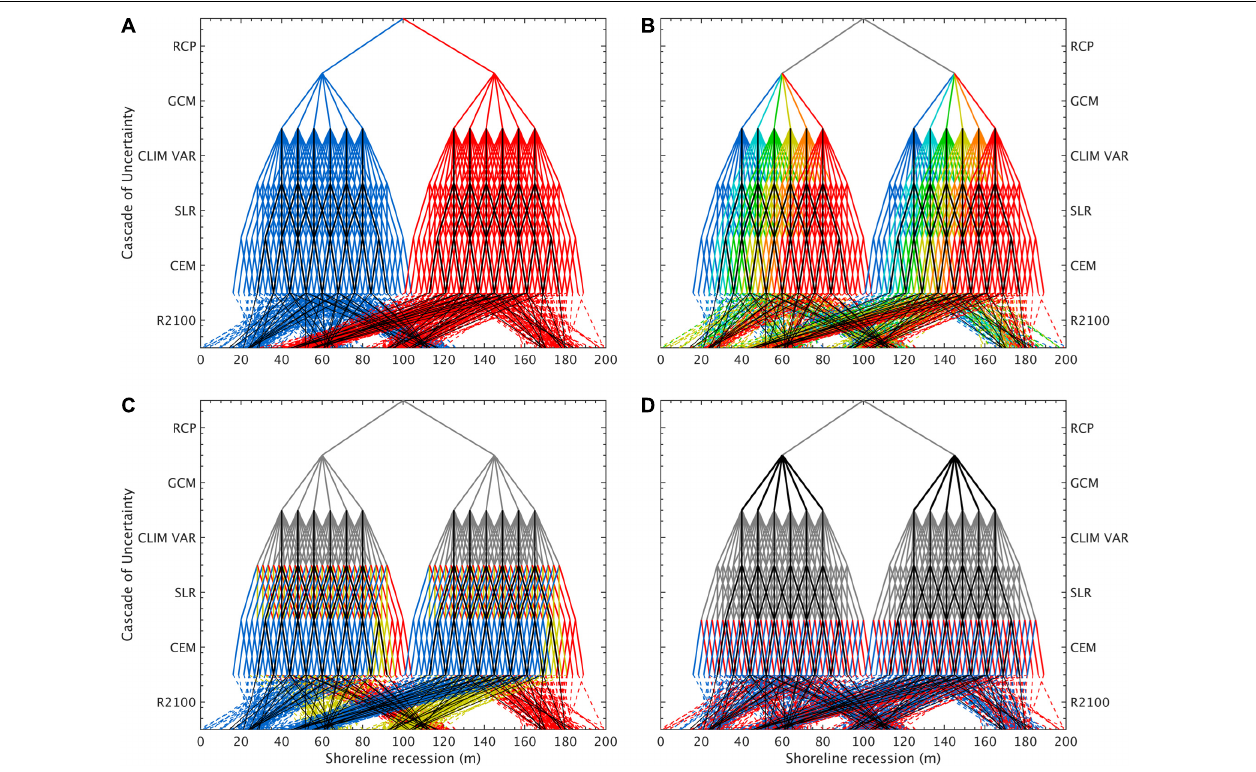
FIGURE 6 | Visualisation of the cascade of uncertainty in coastal erosion projections by 2100 using SP1 and SP3 simulations. SP1 data (720 simulations out of 72,000) is displayed as in Figure 5 and SP3 data (72 simulations) are superimposed and represented by solid black lines. From top to bottom: first layer shows the 2 RCPs, second layer shows the ensemble of 6 GCMs, third layer shows climate variability, fourth layer shows the 3 SLR percentiles, fifth layer shows the ensemble of 2 CEMs and the last layer shows the R2100 indicator (actual values displayed on the horizontal axis). (A–D) illustrate the cascade under four factorisations that highlight the uncertainty spread due to the choice of RCPs, GCMs (considering climate variability realisations), SLR percentiles, and CEMs.